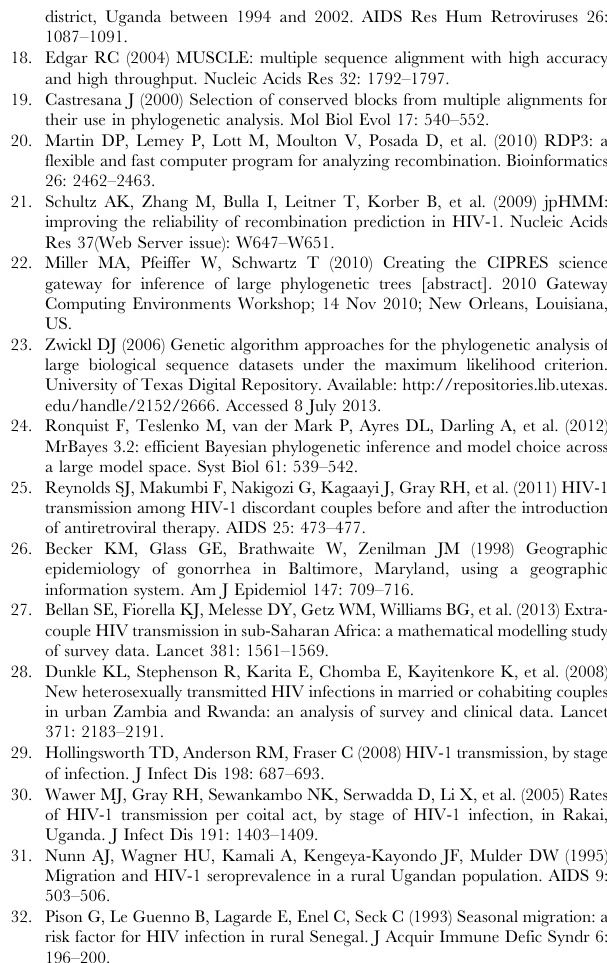
Table S6 Sensitivity analyses of phylogenetic clustering results to choice of evolutionary model and bootstrap and genetic distance thresholds. Phylogenetic cluster analyses were conducted at 70%, 80%, 90%, and 99% bootstrap thresholds, with and without genetic distance cutoffs under the HKY-85 and GTR + I + G models of evolution. We present the cluster summary data shown in Table 2 under these different evolutionary models and genetic distance and bootstrap threshold criteria. Table S7 Numbers of recent sexual partners self- reported by 9,520 HIV-seronegative and -incident par- ticipants in egocentric analysis by gender and marital status of the study participant. Table S8 Summary of self-reported sexual partner data from 9,520 HIV-seronegative and -incident participants in egocentric analysis by gender of the study participant and geographic location of the sexual partner. Table S9 Comparison of demographics and sexual behaviors (percent distribution) between RCCS study population (RCCS R13, 2008–2009) and the